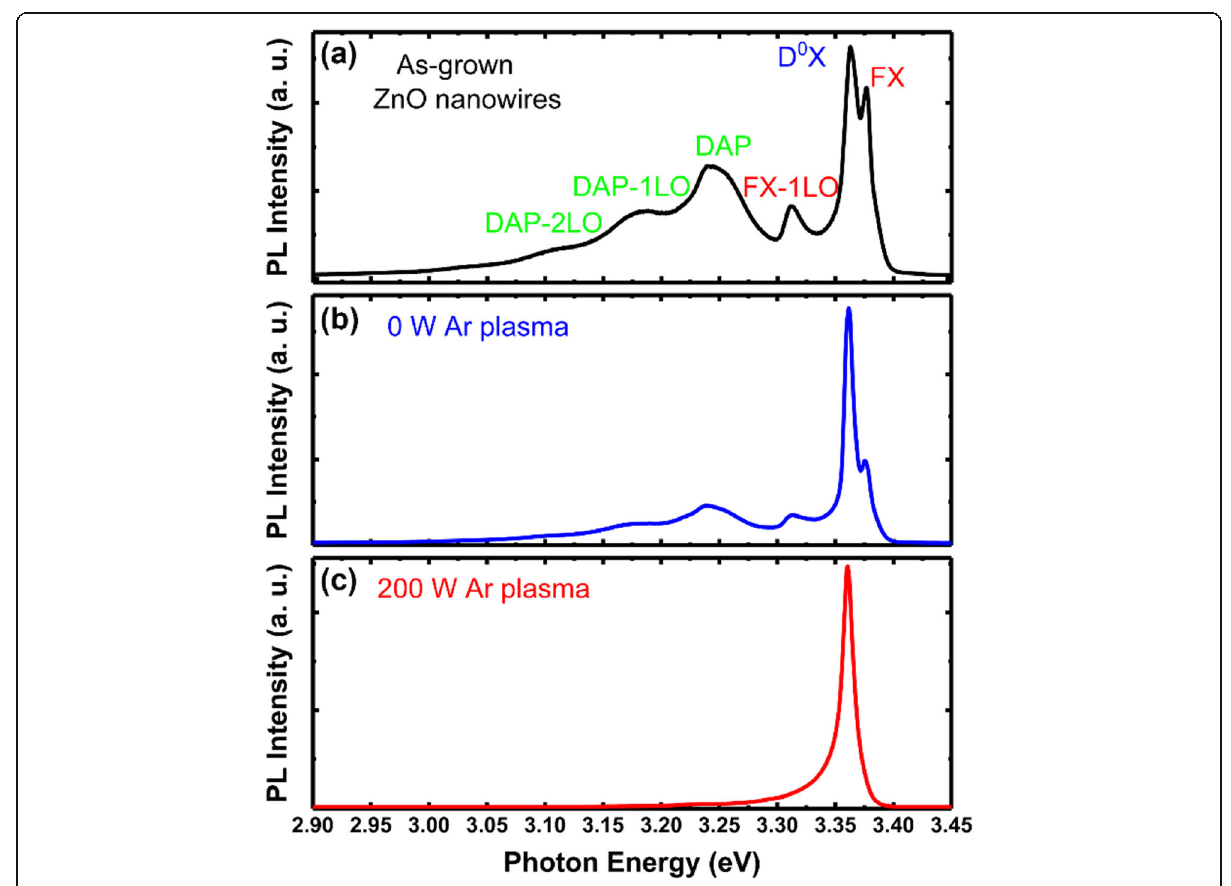
Fig. 3 Low-temperature PL spectra of the ZnO NWs treated by Ar plasma with different energies. a As-grown. b 0 W. c 200